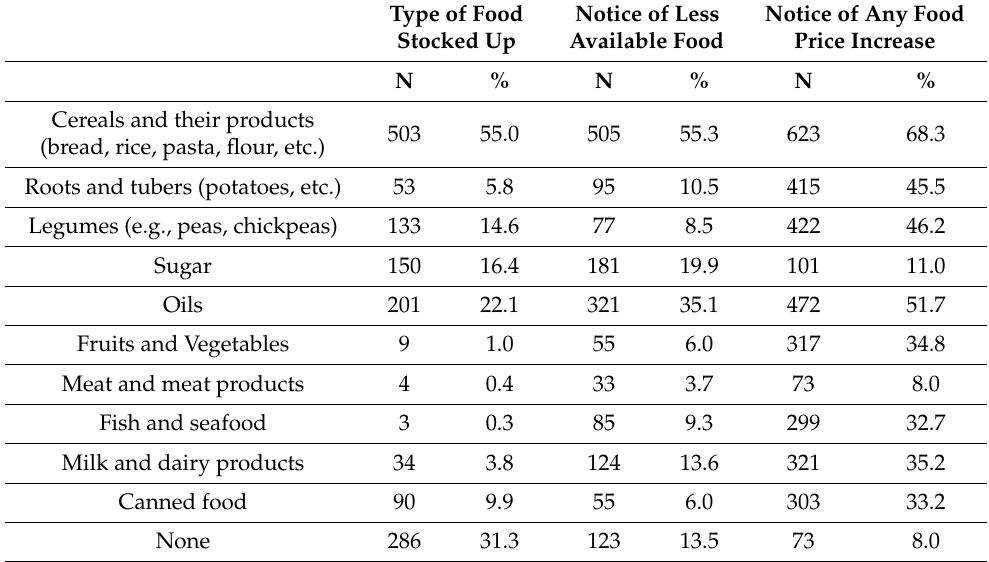
Table 4. Types of foods stocked up, change in food availability, and food price increase during the